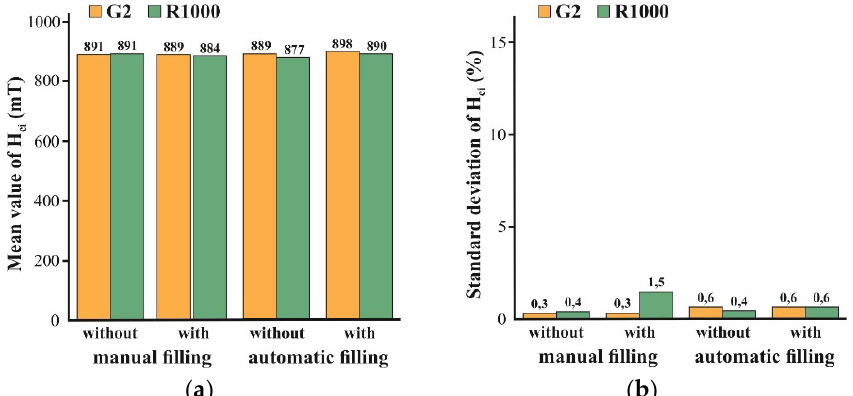
Figure 20. Mean values ( a ) and standard deviations ( b ) of the intrinsic coercivity H ci for micromagnets of designs G2 and R1000 from substrates that were processed using manual or automated mold filling with or without compaction. From each substrate, 16 chips of each design were picked and measured. The corresponding B r values are summarized in Figure 14.